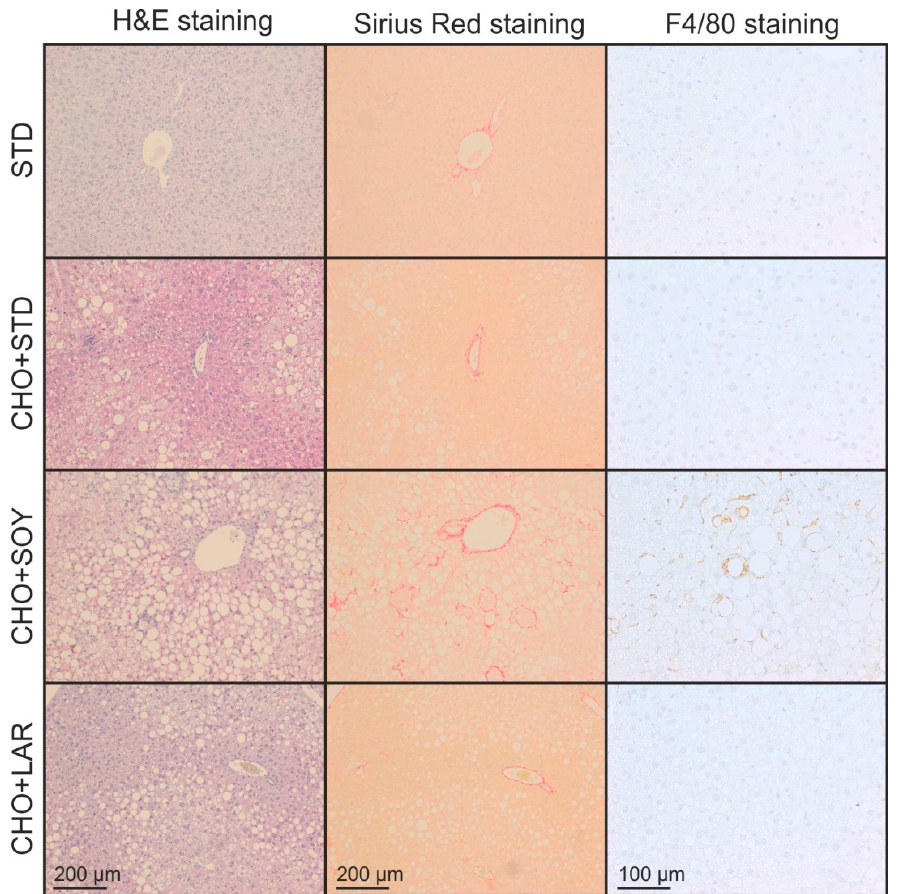
Figure 4. CHO + SOY diet induced steatohepatitis with steatosis, fibrosis, and macrophage infiltration. Mice received the diets for 20 weeks. Representative microphotographs of liver sections, magnification 10× or 20×.